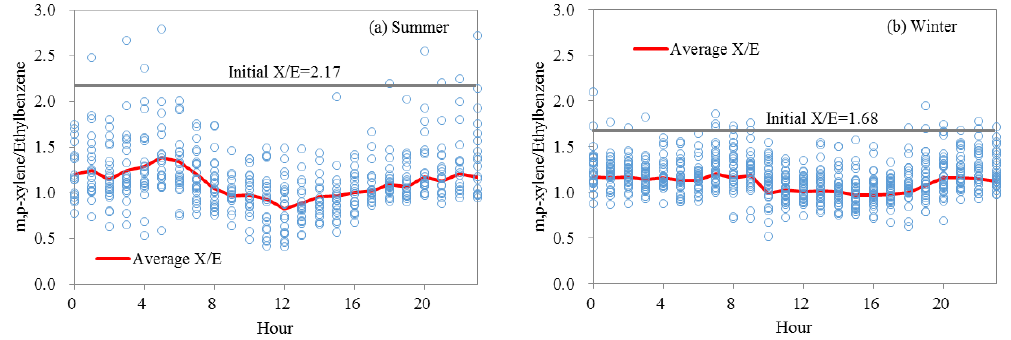
Figure 3. Diurnal distributions of the ratios of m , p -xylene to ethylbenzene concentrations in summer and winter in the urban atmosphere in